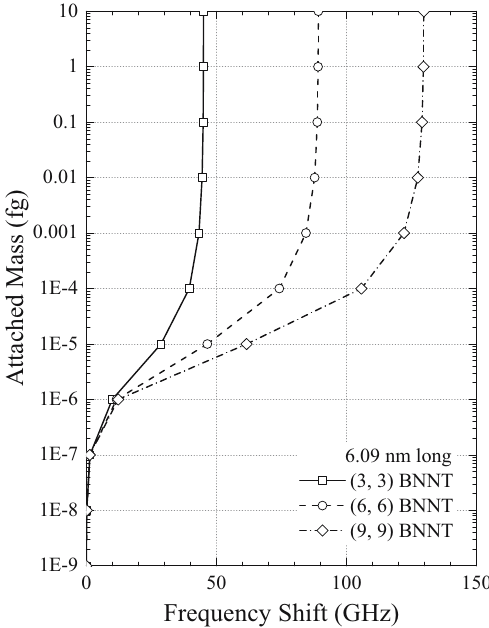
Figure 8: Frequency shifts for ( 3,3 ) , ( 6,6 ) , and ( 9,9 ) cantilevered SW - BNNT with length 8.13 nm for di ff erent attached